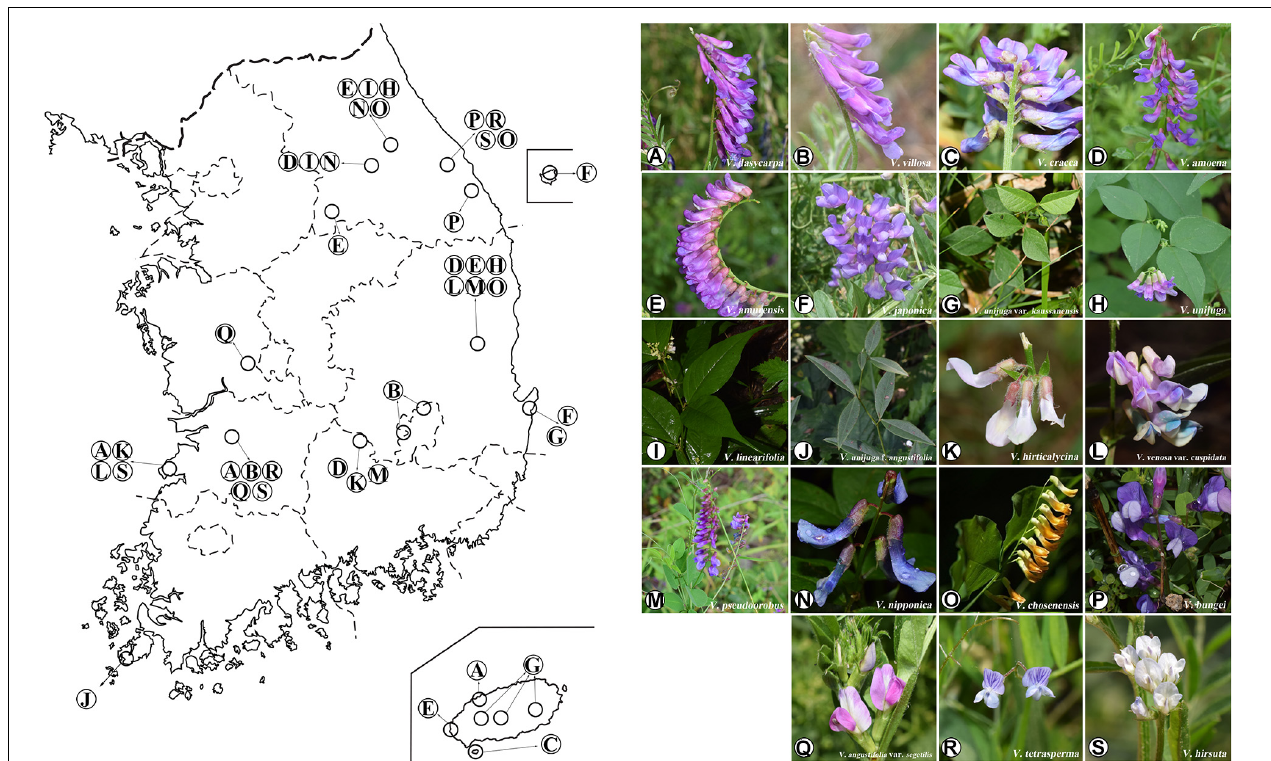
FIGURE 1 | Collection sites of Vicia species in Korea. (A) V. dasycarpa ; (B) V. villosa ; (C) V. cracca ; (D) V. amoena ; (E) V. amurensis ; (F) V. japonica ; (G) V. unijuga var. kaussanensis ; (H) V. unijuga ; (I) V. linearifolia ; (J) V. unijuga f. angustifolia ; (K) V. hirticalycina ; (L) V. venosa var. cuspidata ; (M) V. pseudo-orobus ; (N) V. nipponica ; (O) V. chosenensis ; (P) V. bungei ; (Q) V. angustifolia var. segetilis ; (R) V. tetrasperma ; (S) V. hirsuta